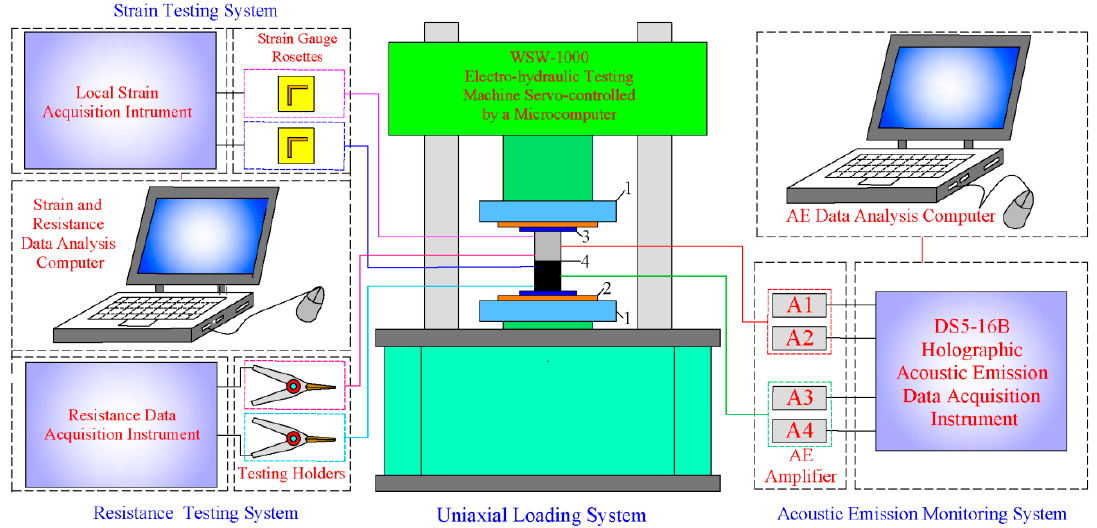
Figure 4. Experimental system for the sandwiched coal-rock specimen in the uniaxial compressive test. (1—loading plates; 2—insulation boards; 3—copper electrodes; 4—testing sandwiched coal-rock specimen.)